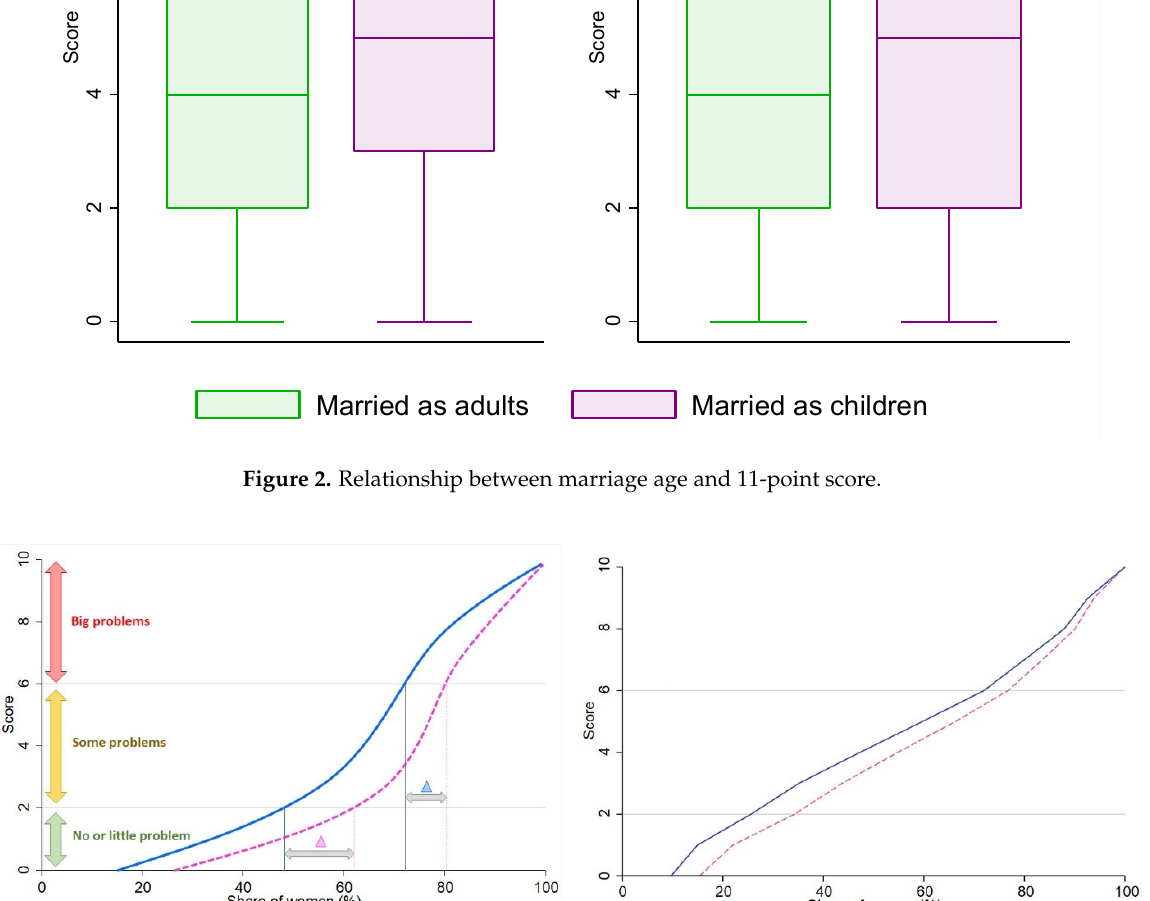
Figure 2. Relationship between marriage age and 11 ‐ point score.